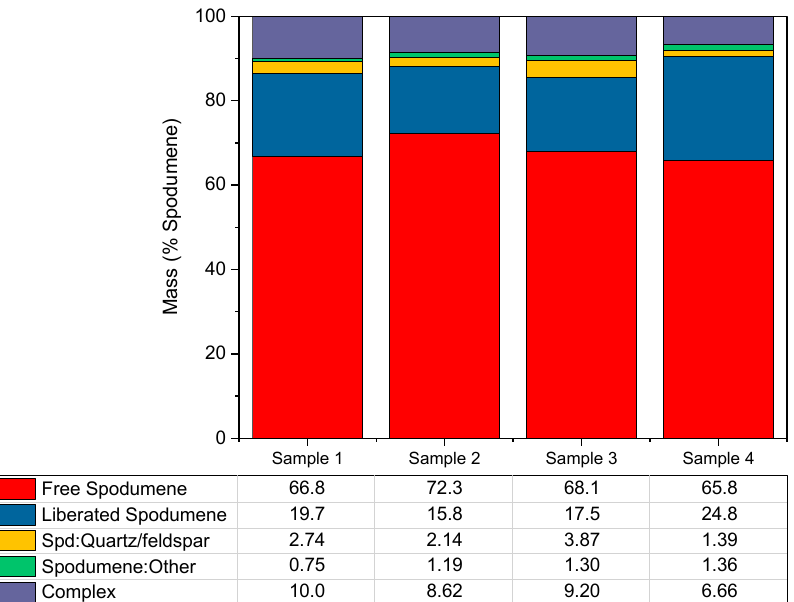
Figure 4. Summary of spodumene liberation and association profile (mass% calculated for the head samples) at a P 80 of 425 µm.